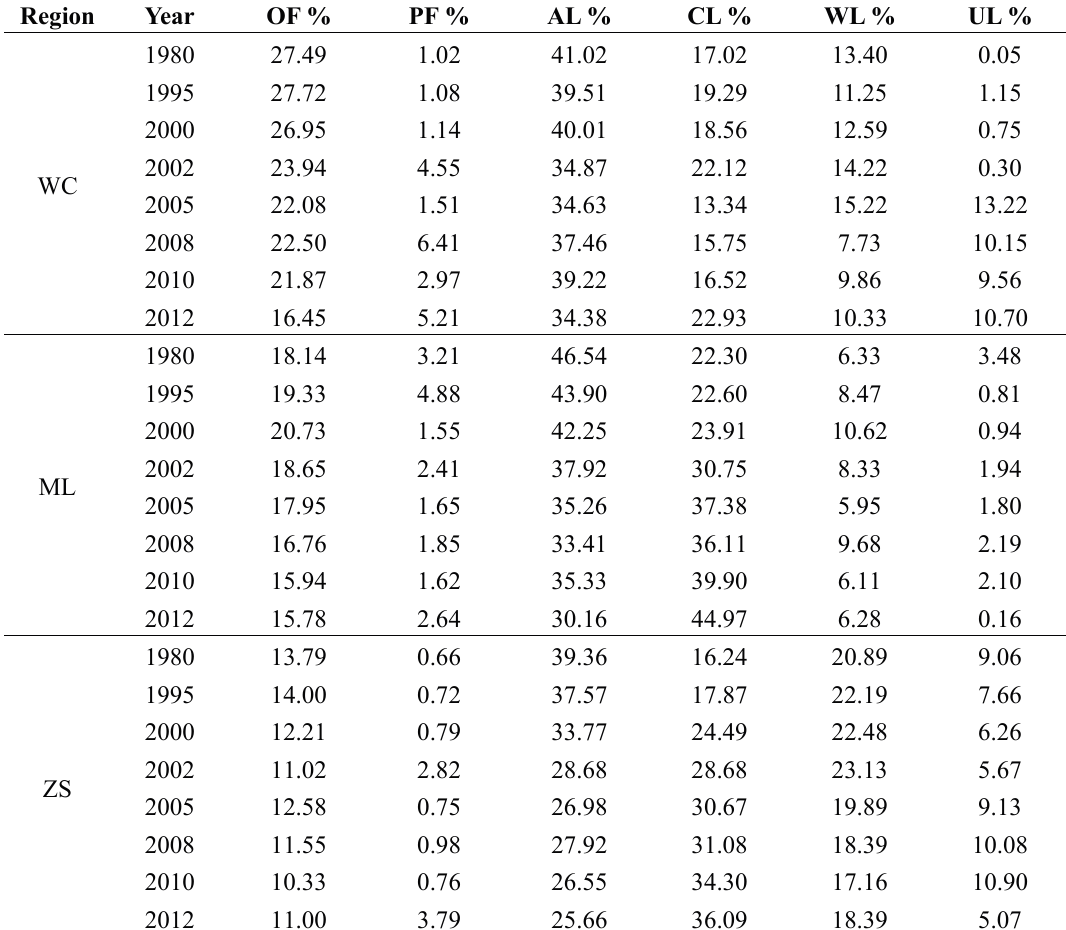
Table 1. Statistical data of each land use proportion within the full temporal series. Region Year OF % PF % AL